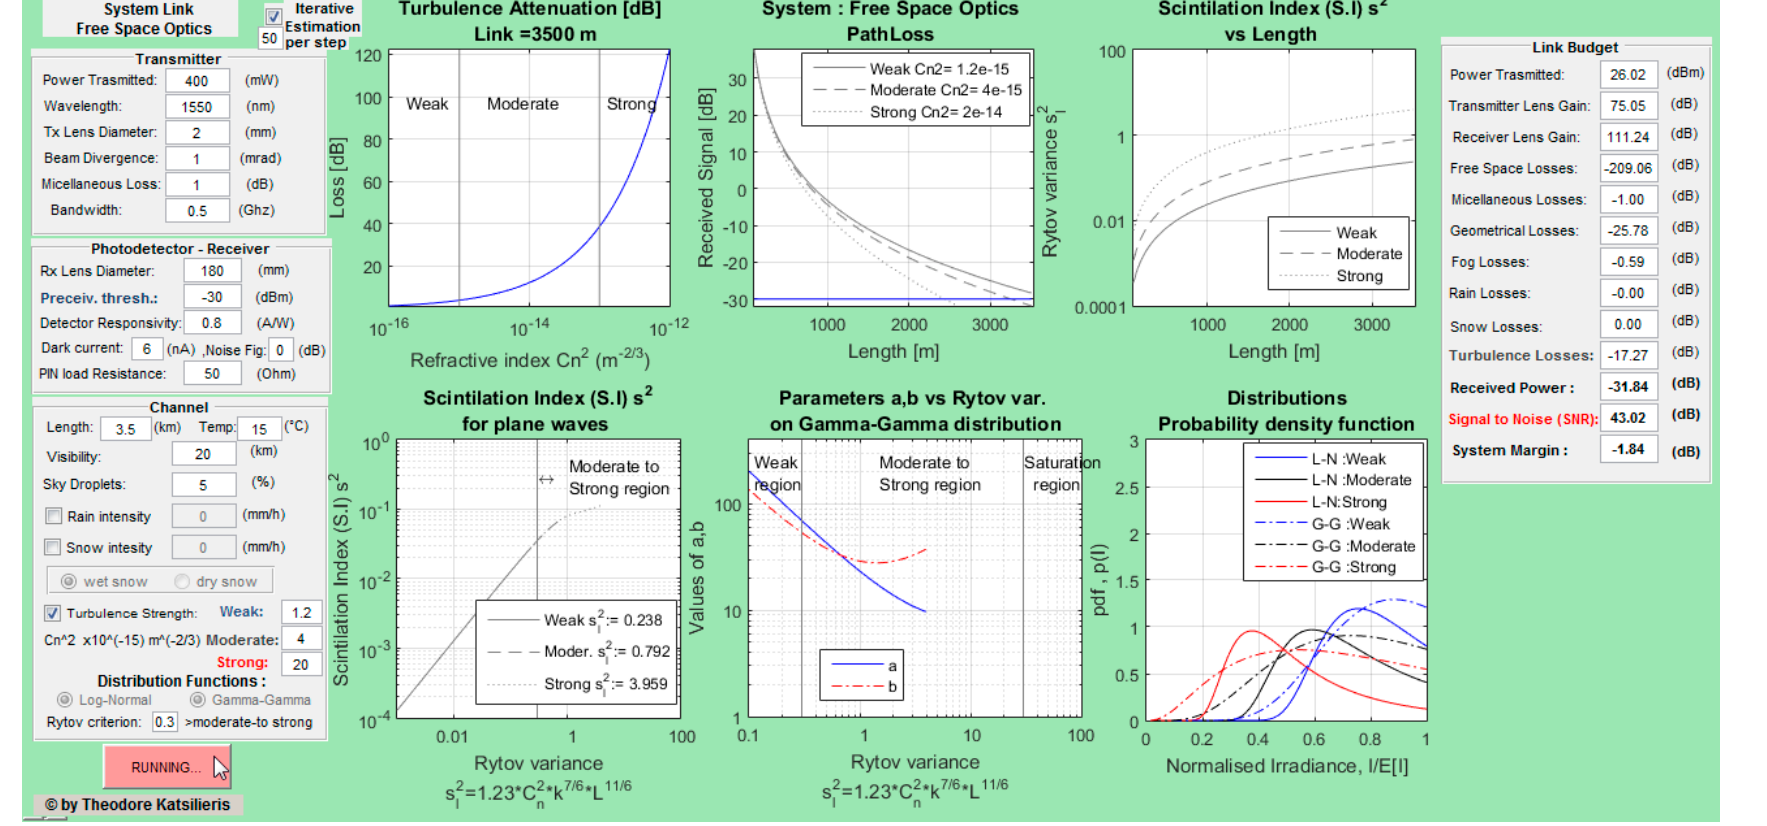
Figure 2. The computation tool interface.